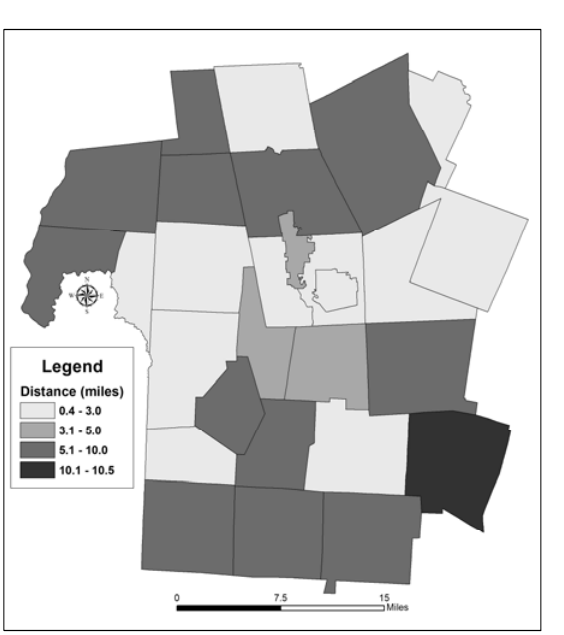
Figure 5. Maps Illustrating the Average (A) and Maximum (B) Distance to Food Providers with a High Likelihood of Selling Processed Food Within Rutland